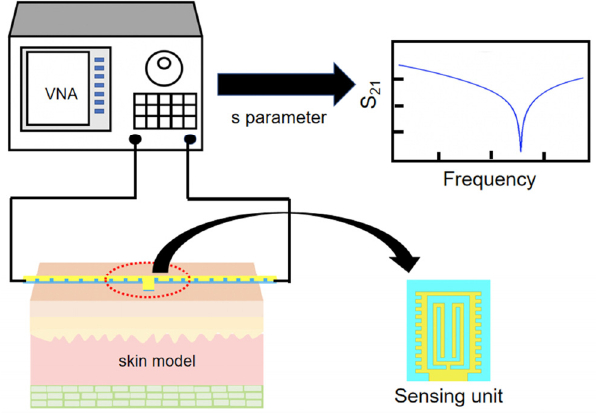
Figure 1. Working principle of sensor.